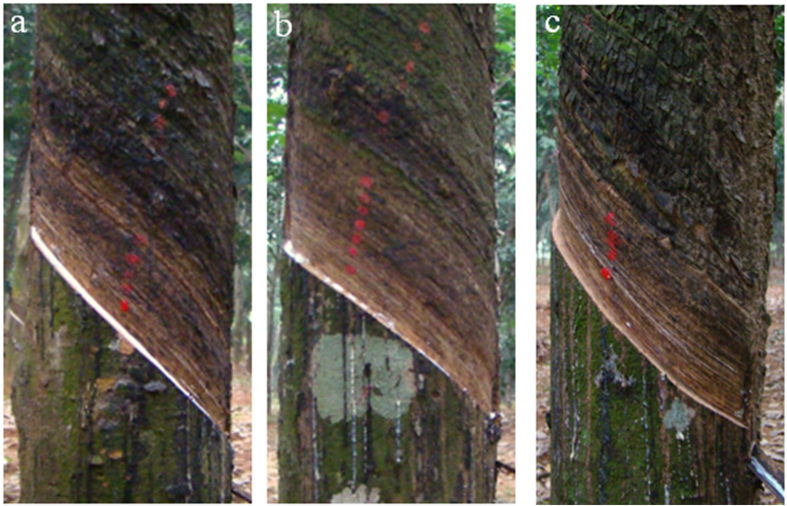
Images of healthy and TPD rubber trees.(a) A healthy rubber tree with normal latex flow. (b) A rubber tree partially affected by TPD in which latex flow is observed in patches. (c) A rubber tree completely affected by TPD in which no latex flow is observed.